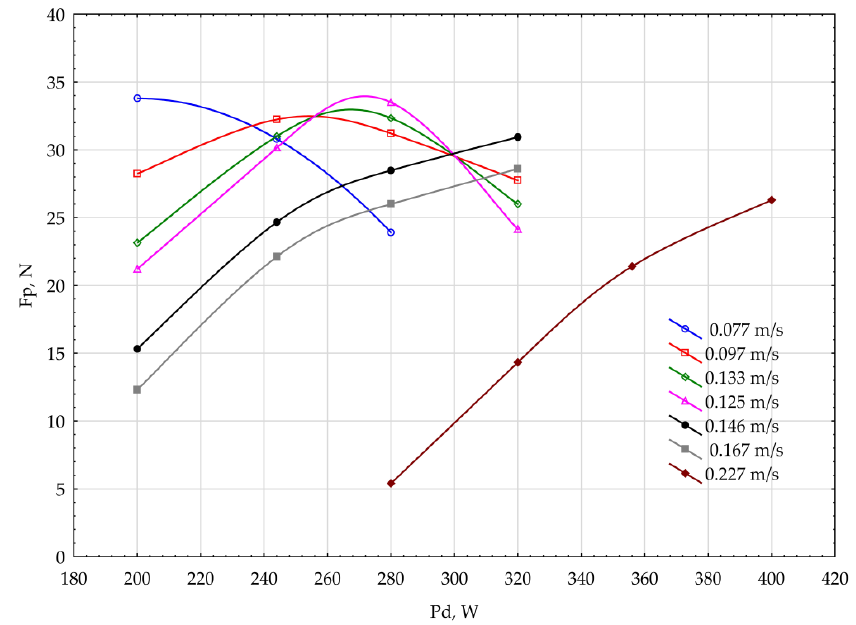
Figure 8. A diagram showing the functional relationships between the breaking forces of ultrasonic welds and the speed at which specimens are welded using a rotary ultrasonic sonotrode in relation to the declared electrical power of the ultrasonic generator.